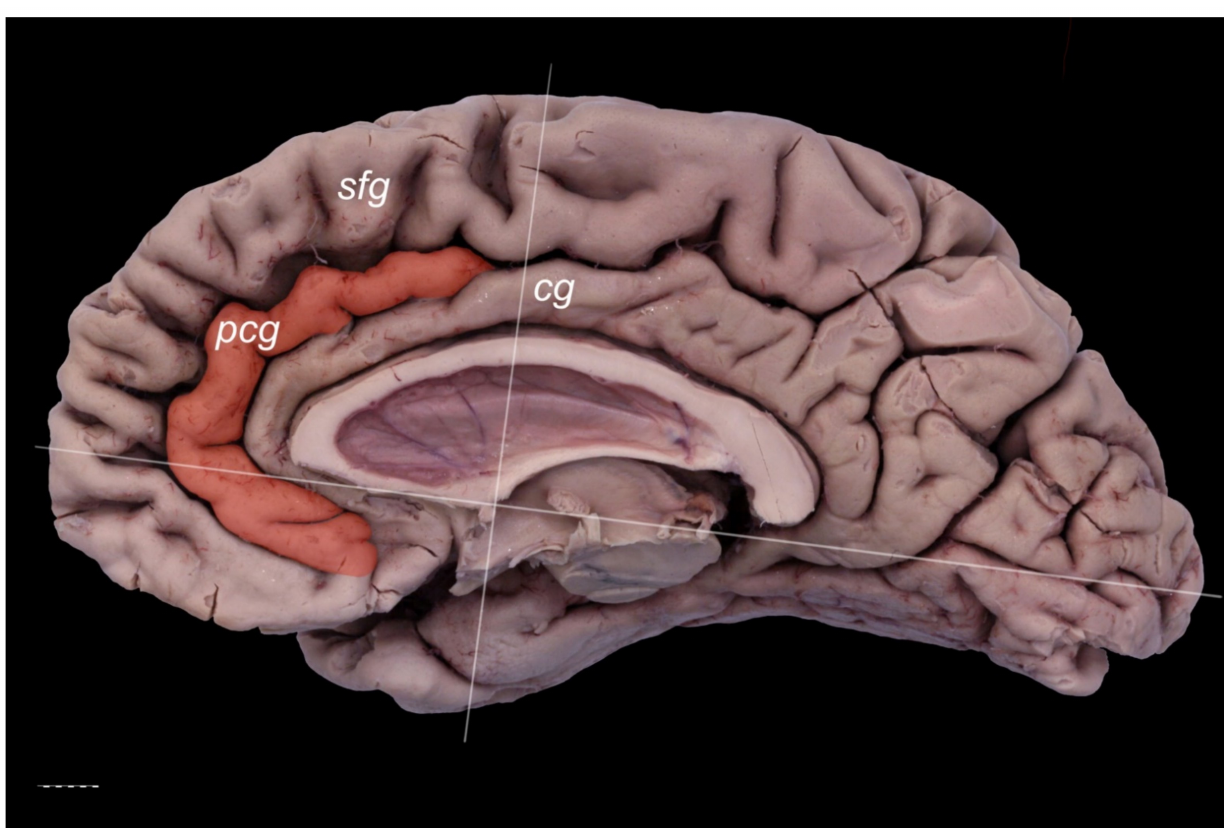
Figure 5. An ambiguous case of a PCG (orange). Medial view of the right cerebral hemisphere. The gyrus is well-developed, although only about 5 mm is missing in order to classify this specimen as “prominent” as it ends slightly anterior to the level of the VAC line. The VAC and AC-PC lines are marked. cg—cingulate gyrus; pcg—paracingulate gyrus; sfg—superior frontal gyrus. The scale bar corresponds to 10